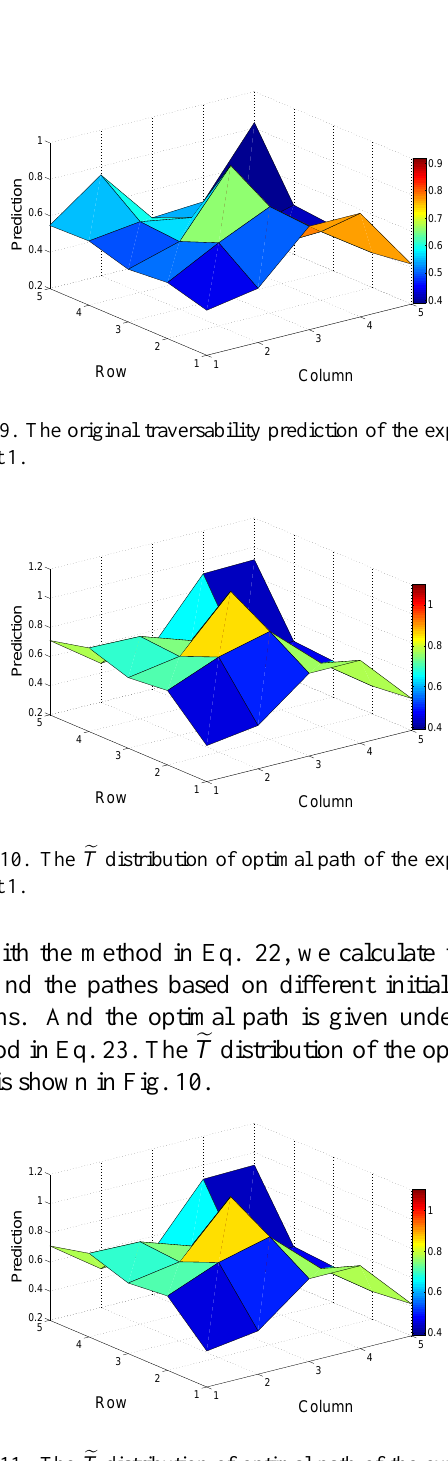
Fig. 11. The T distribution of optimal path of the experi- ment 1. e